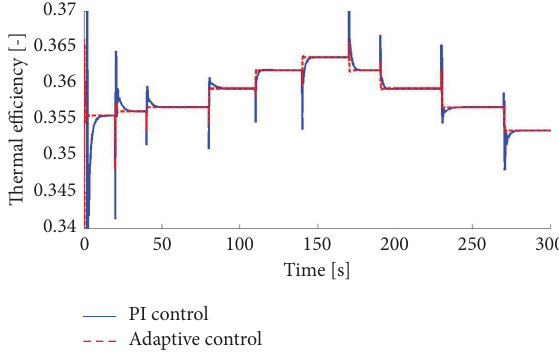
Figure 10: Termal